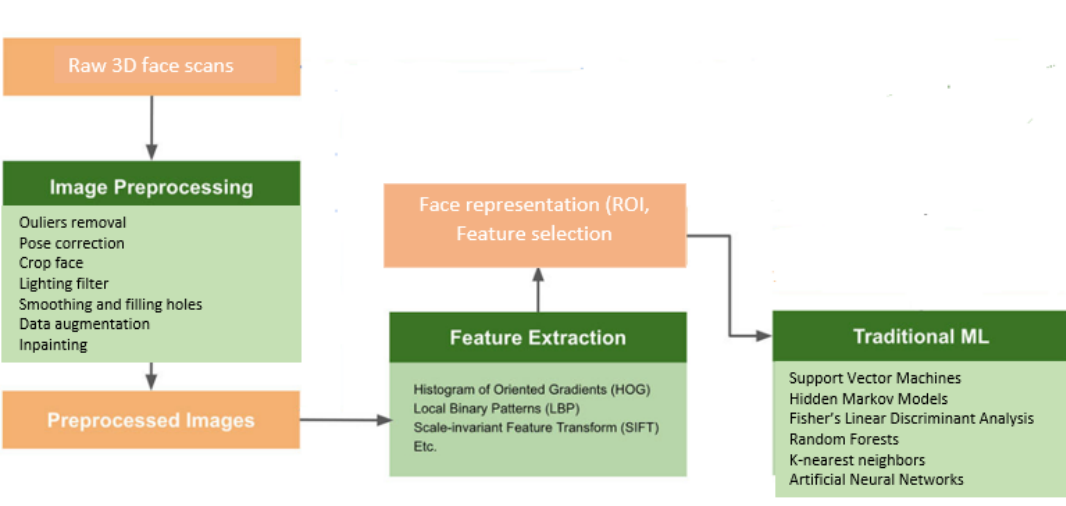
Figure 39. Summary of the usual pipeline in 3D face recognition.